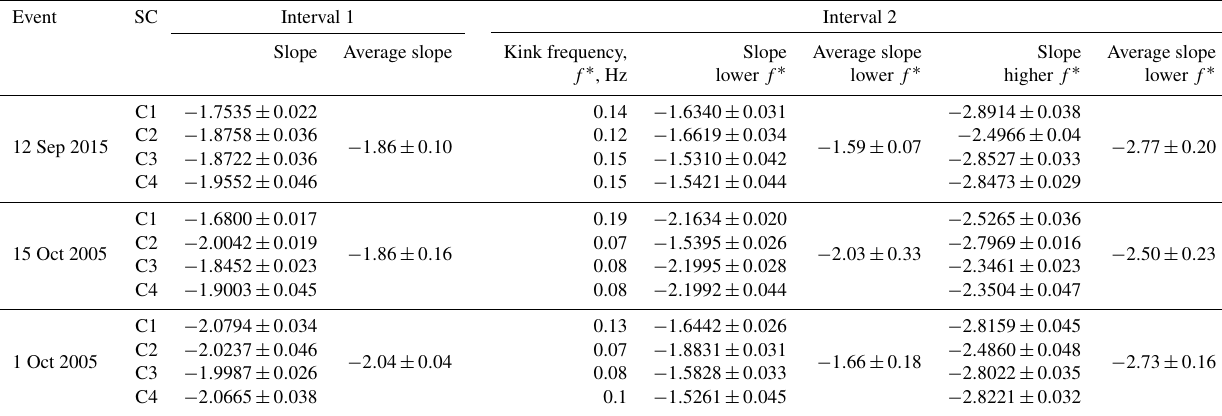
Table 3. The results of PSD analysis. Event SC Interval 1 Interval 2 Slope Average slope Kink frequency, Slope Average slope Slope Average slope f ∗ , Hz lower f ∗ lower f ∗ higher f ∗ lower f